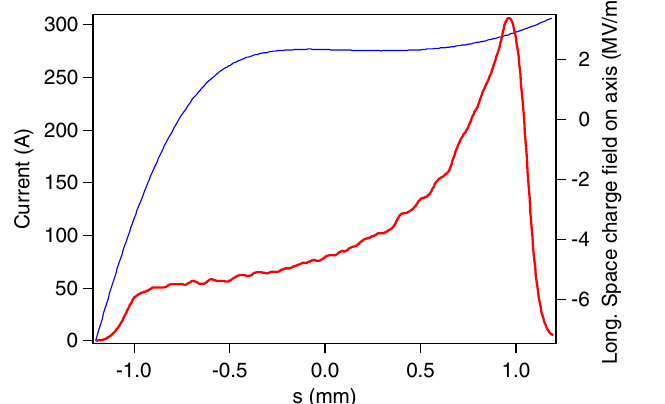
FIG. 6. Electron distribution in the longitudinal phase space: (a) before bunch compressor, (b) after the bunch compressor.